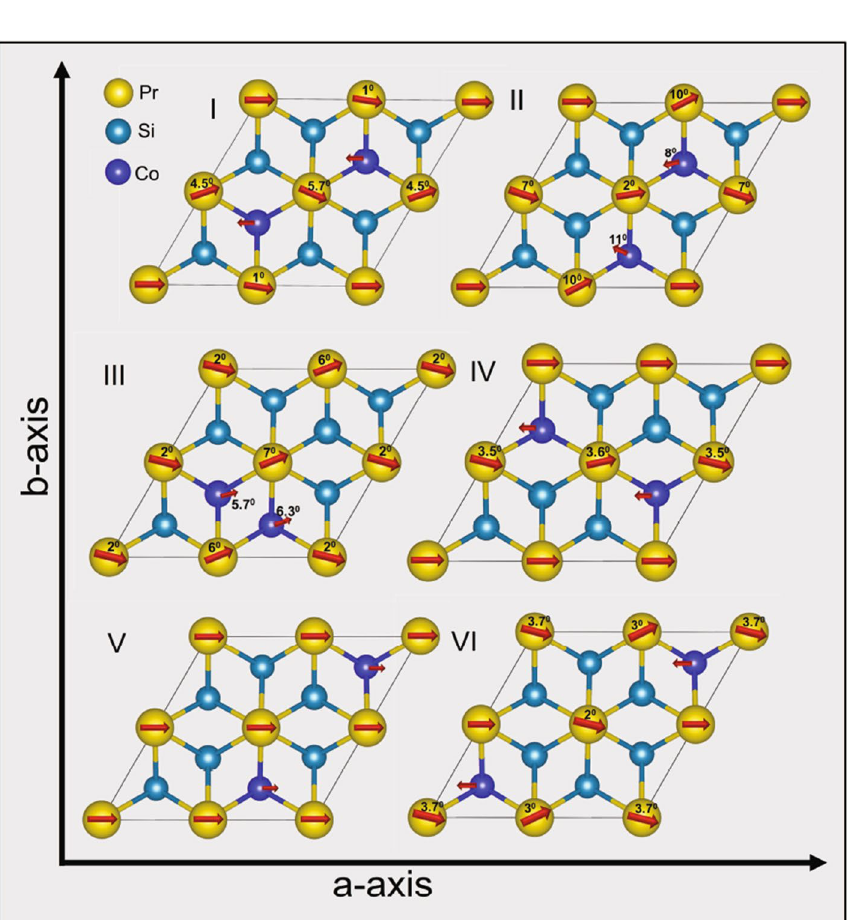
Figure 5. 2D-view of Pr 2 CoSi 3 structure belonging to AlB 2 -type crystal structure by considering a 2 a × 2 b × c supercell. The angle between a - and b -axis, as presented in the figure, is 60 ◦ . Depending on the relative positions of Co and Si atoms, six different configurations are allowed. The configuration I, belonging to the U 2 RuSi 3 -type superstructure, is found to be energetically most stable. The spin rotation angles around the a -axis are also displayed along with the respective atomic